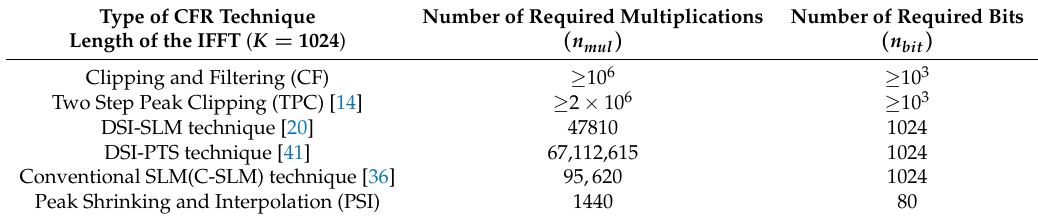
Table 4. Computational complexity